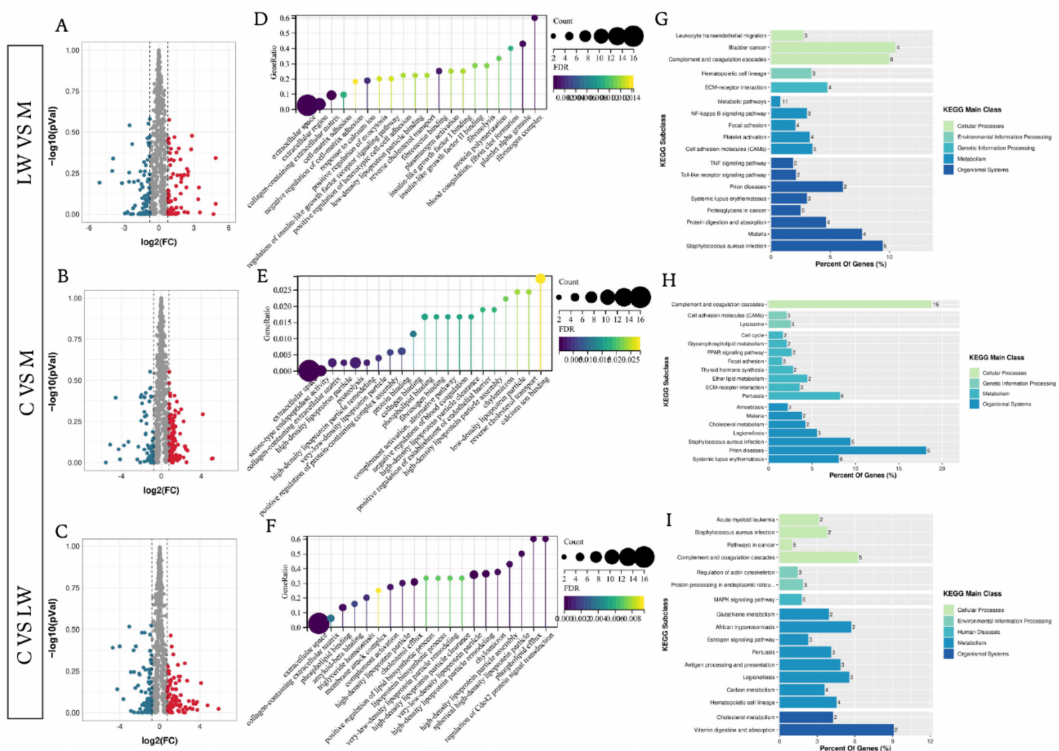
Figure 1. Visualization of proteomic results between different pig breeds. ( A – C ) Volcano plots of comparation for Large white (LW) with Min pig (M), M with cross-bred of LW × M ( C ), and LW with C. Significantly differentially expressed proteins are highlighted in red and green, and grey dots represent non-differentially expressed proteins. ( D – F ) Enrichment analysis using gene ontology (GO) for LW with M, M with C, and LW with C. ( G – I ) Bar diagram of partial significantly enriched pathways for LW with M, M with C, and LW with C DE